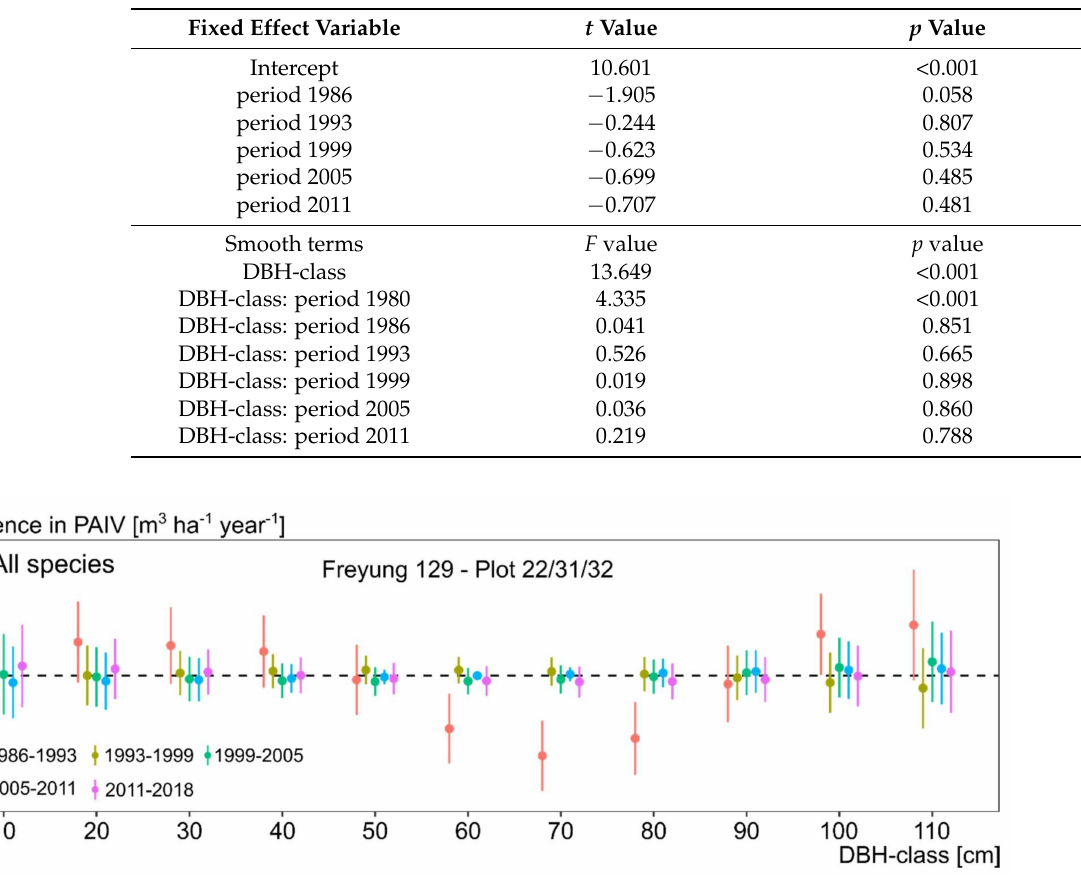
Figure 6. Differences in stand level size-class volume growth between subsequent observation periods modeled according to Equation (7) on the subplots FRY 129/22, 31, and 32. The deviations in the periodic volume increment in the respective 10 cm DBH-class between the recording periods 1986–1993, 1993–1999, 1999–2005, 2005–2011 and their respective previous recording period are shown. Dots indicate the mean; lines represent the confidence interval. If the confidence interval does not touch the dashed line (y intercept = 0), there is a significant deviation from the previous period in the respective